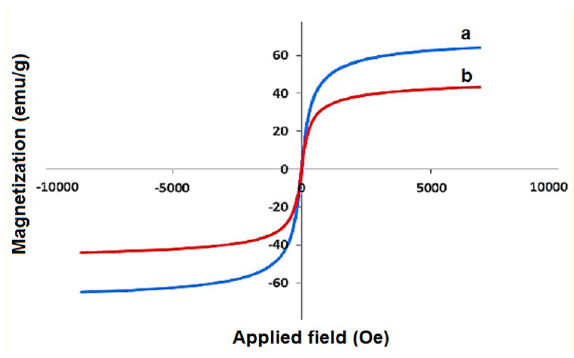
Figure 6. VSM analysis of the ( a ) Fe 3 O 4 and ( b ) Fe 3 O 4 @ SiO 2 @IL-PMO/Pd.